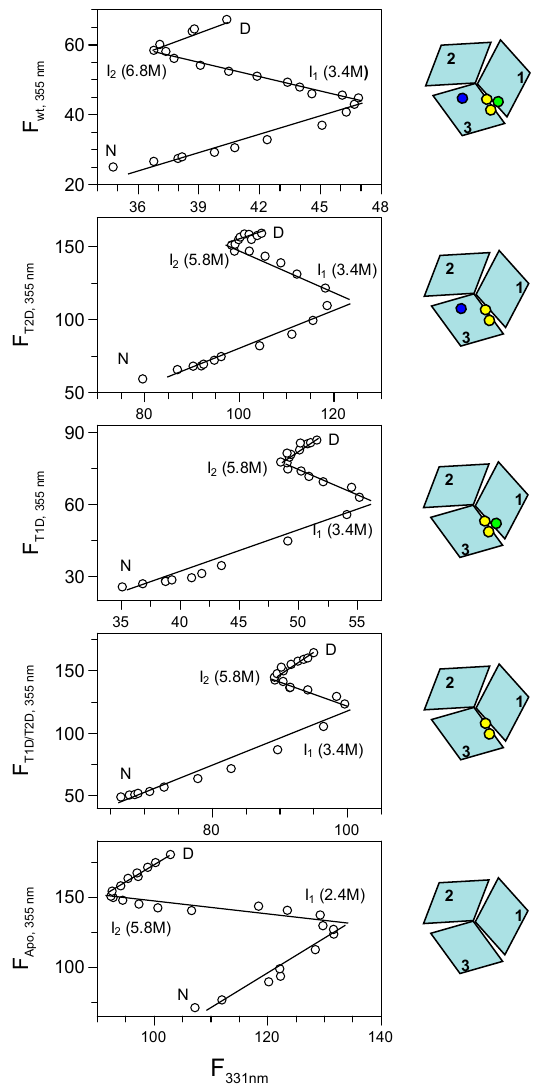
Figure 3. Phase diagram method analysis of holo-, T2D, T1D, T1D/T2D and apo-Fet3p variants (top to bottom) using fluorescence intensities at 331 nm and 355 nm (upon excitation at 295 nm) as the two extensive variables. All phase diagrams indicate the population of two intermediates, which are highly populated at the indicated concentrations of urea.